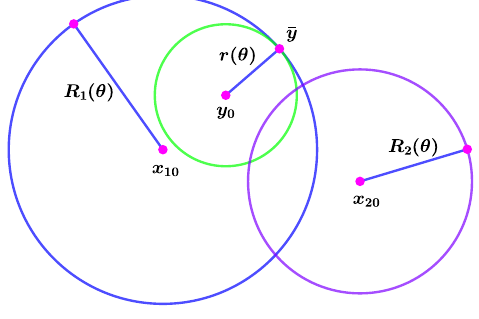
Figure 2. Case 1: H ( y 0 , r ( θ )) ⊂ H ( x 10 , R 1 ( θ ))